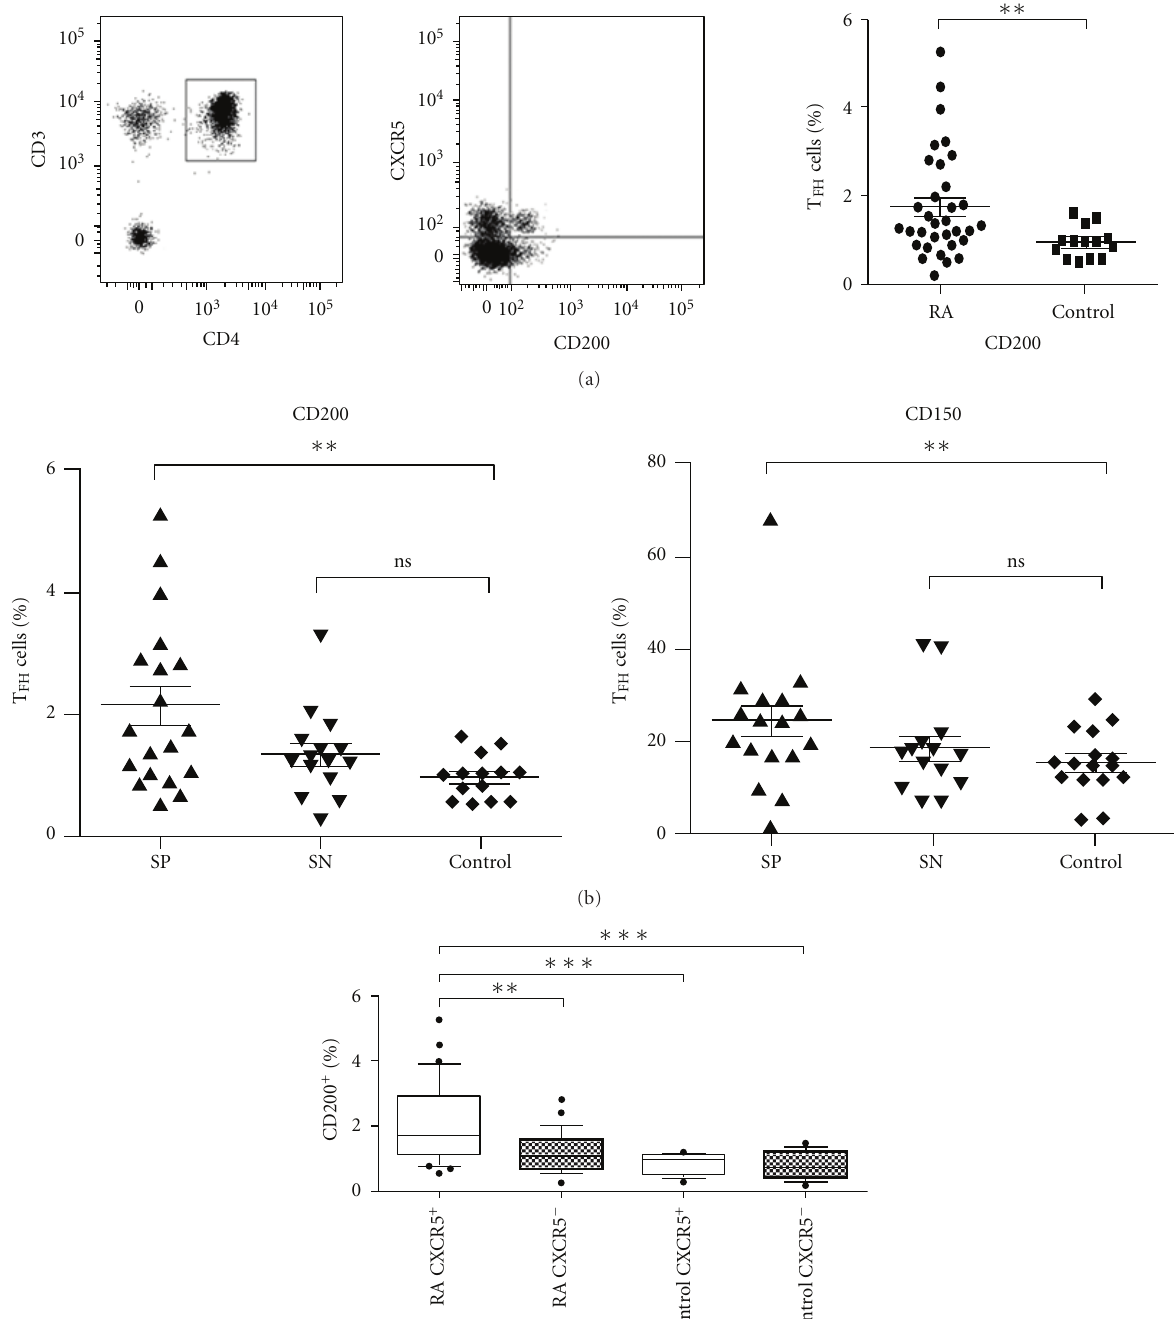
Figure 3: Analysis of receptors expressed by T FH cells. (a) Representative gating strategy showing the increased expression of CD200 on T FH cells from patients with RA. (b) Significantly increased expression of CD200 and CD150 was detected on circulating T FH cells from seropositive RA patients (SP: seropositive, SN: seronegative) ( P = 0 . 0045 and P = 0 . 0088, resp.). Each spot represents an individual patient, and the mean ± SEM are shown. (c) CD200 expression is enriched on CXCR5 positive CD4 + T cells in patients with